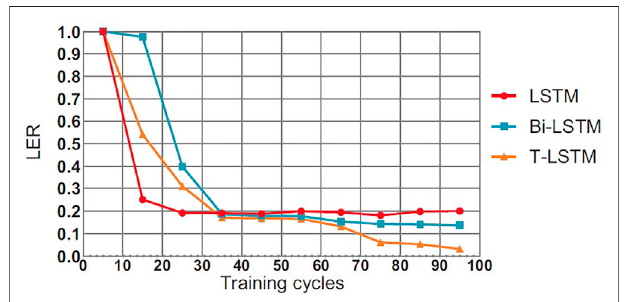
FIGURE 7 | Comparison of convergence Rec results between T-LSTM and BI-LSTM and